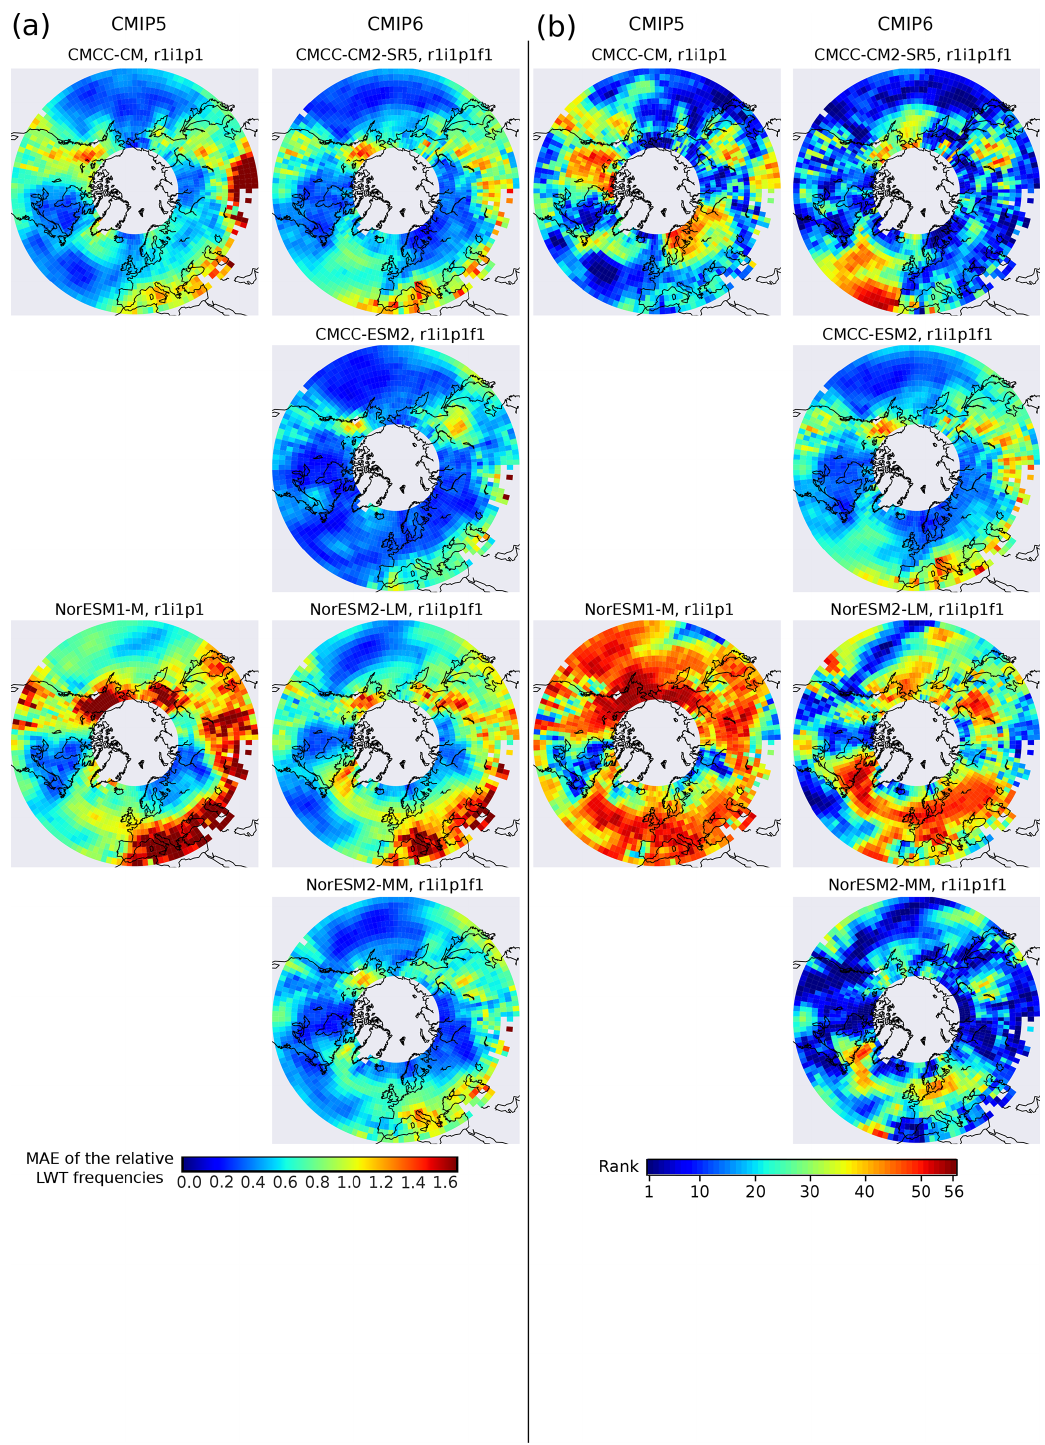
Figure 10. As Fig. 3 but for the CMCC and NorESM models.